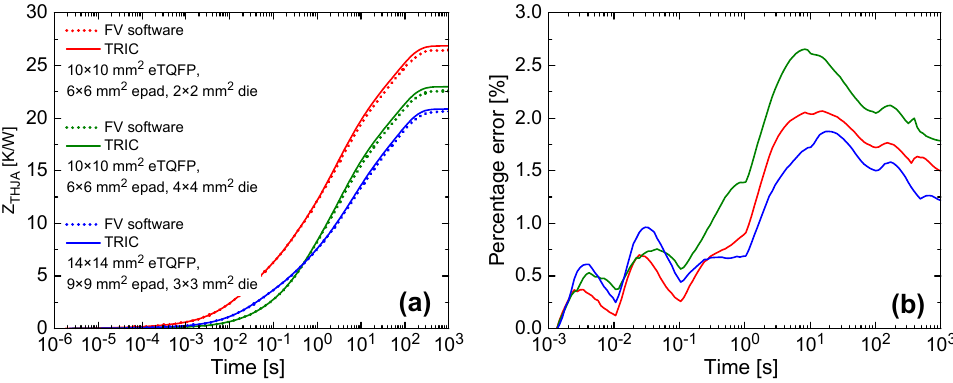
Figure 12. ( a ) Comparison between TRIC and FloTHERM for various eTQFP cases; ( b ) corresponding percentage error vs. time.